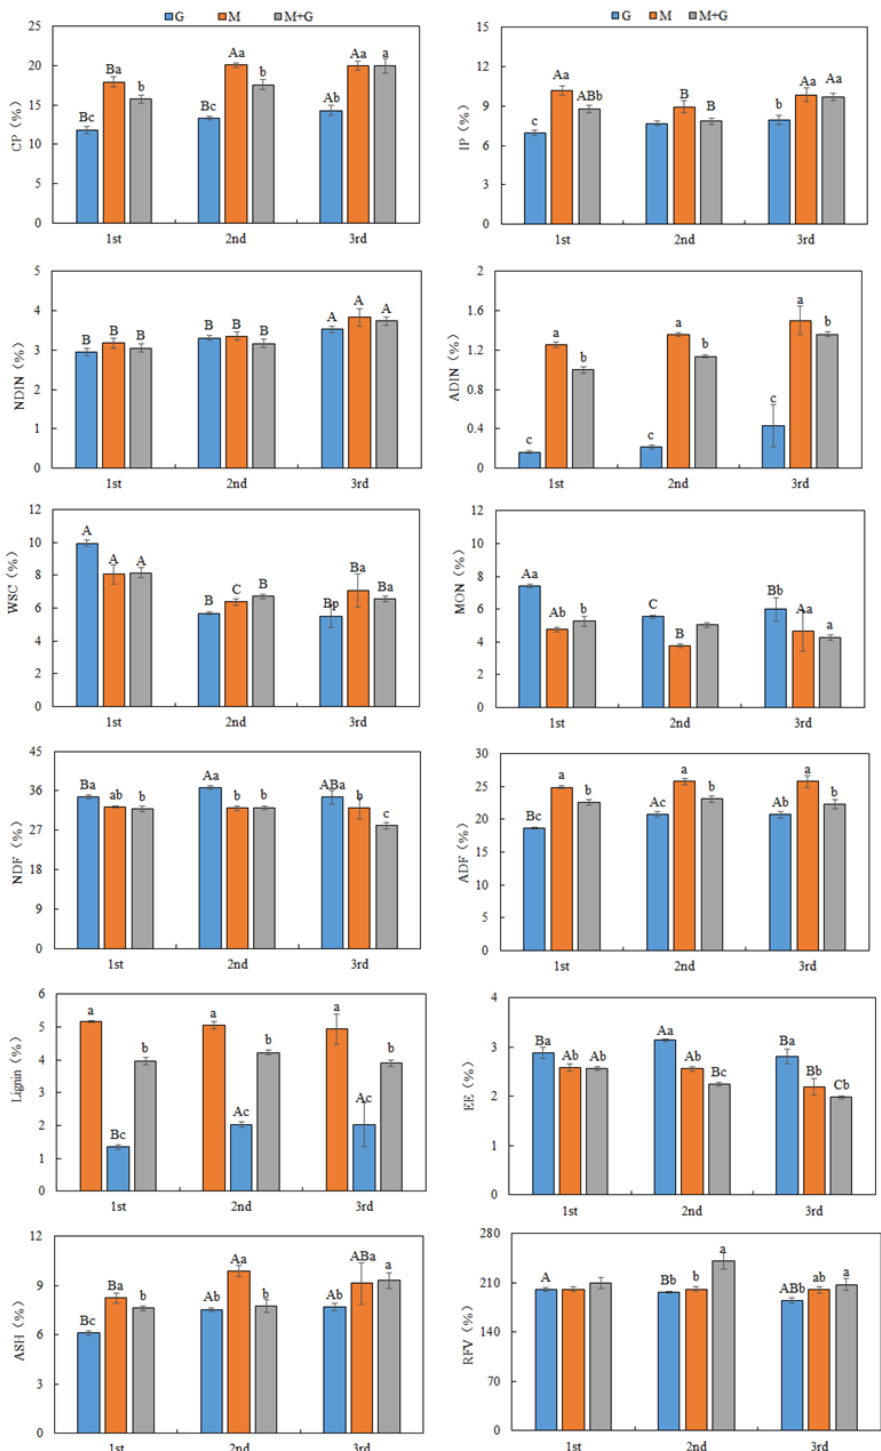
Figure 1. Characteristics of nutrient compositions of forages of three cultivated grasslands under different stubble cutting times. Crude protein (CP), ether extract (EE), ash (ASH), water soluble carbohydrate (WSC), monosaccharide (MON), insoluble protein (IP), neutral detergent insoluble fiber (NDIF), acid detergent insoluble fiber (ADIF), neutral detergent fiber (NDF), acid detergent fiber (ADF) and relative feed value (RFV). Different capital letters indicate the differences among the same forage in different stubbles, and lowercase letters indicate the differences among different forages in the same